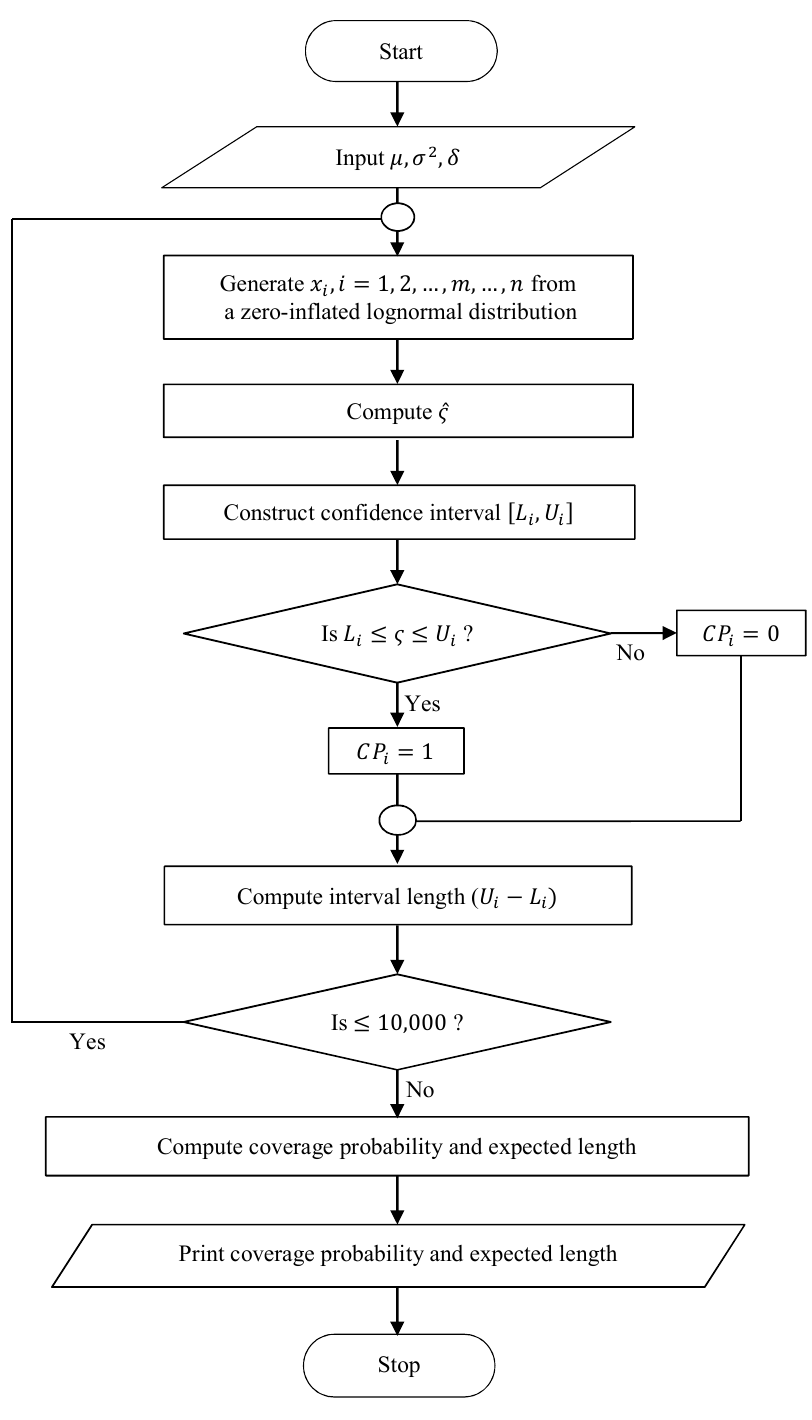
Figure 1. Flowchart of the research